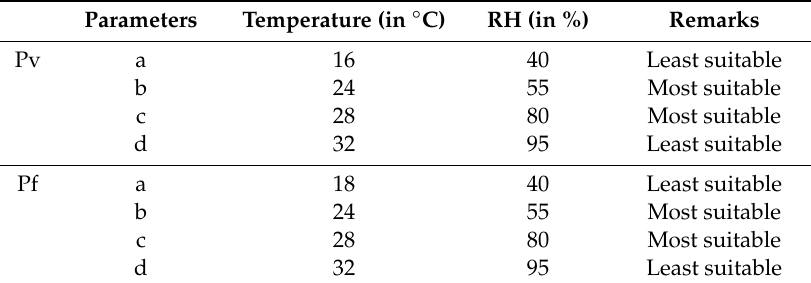
Table 1. The scalar parameters of the